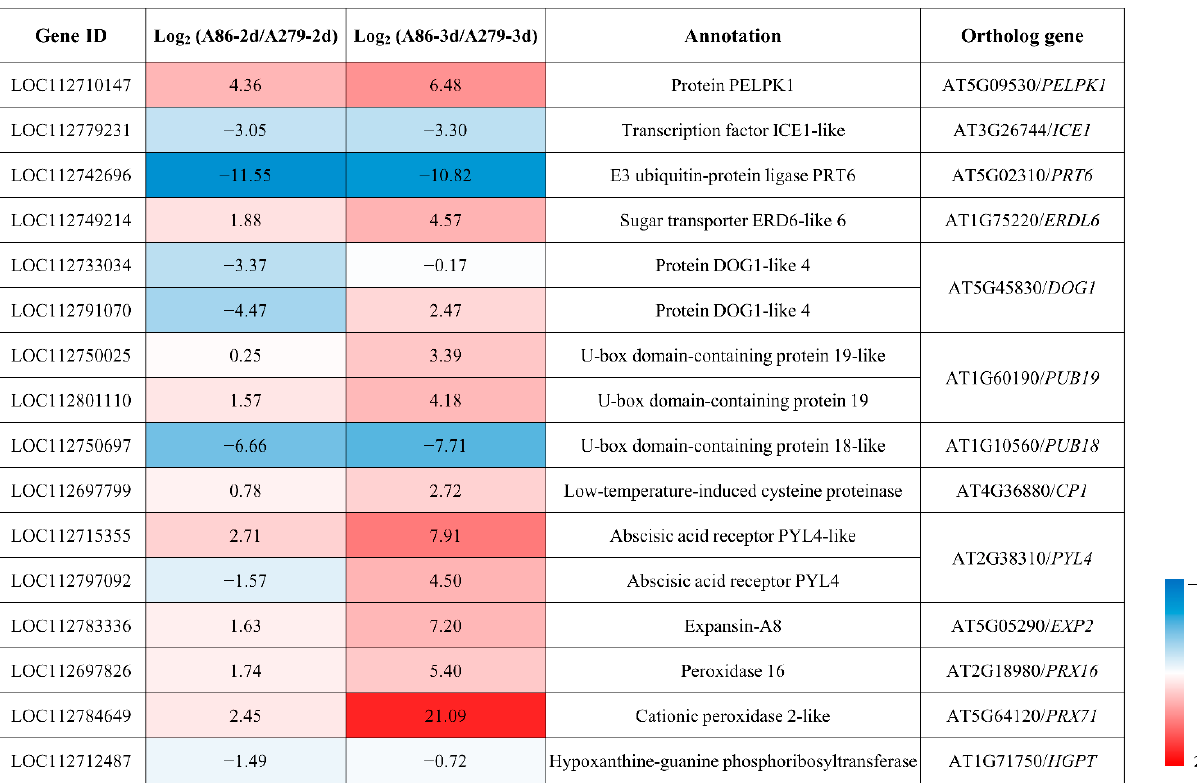
Figure 8. A heat-map showing the differences in expression of 16 genes possibly involved in Figure 8. A heat ‐ map showing the differences in expression of 16 genes possibly involved in seed seed germination.